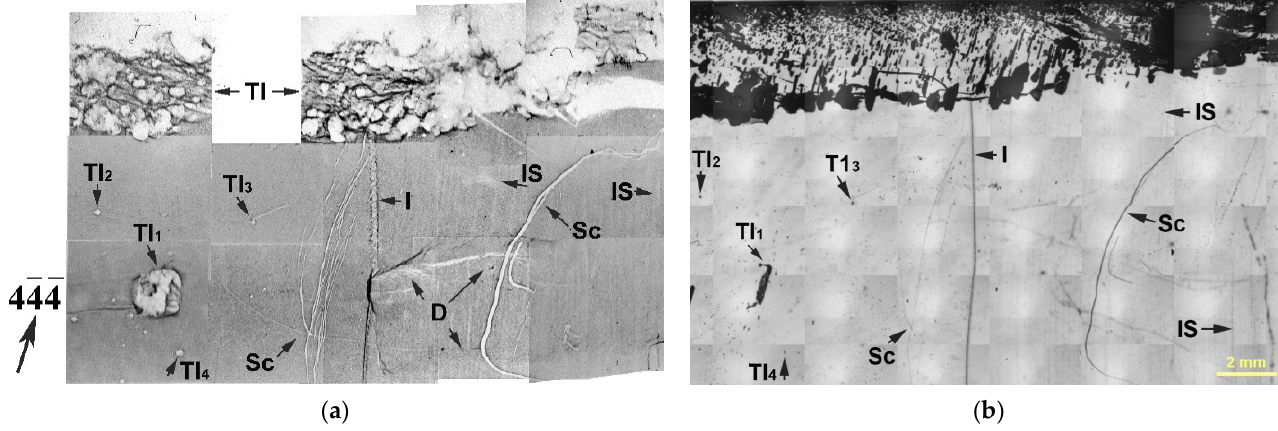
Figure 6. XWBT back reflection mapping ( a ) and infrared image ( b ) near the interface region of F1-02. Some scratches (Sc) exist on the surface. The observation of white dots suggests the stress induced by Te inclusions (TI 1 –TI 4 ). Extensive distortion and dislocation networks (D) accumulate at the interface and further extend into the grown crystal region. White streaks prevail the grown crystal, which are considered to be caused by the inclusion striations (IS) [15].